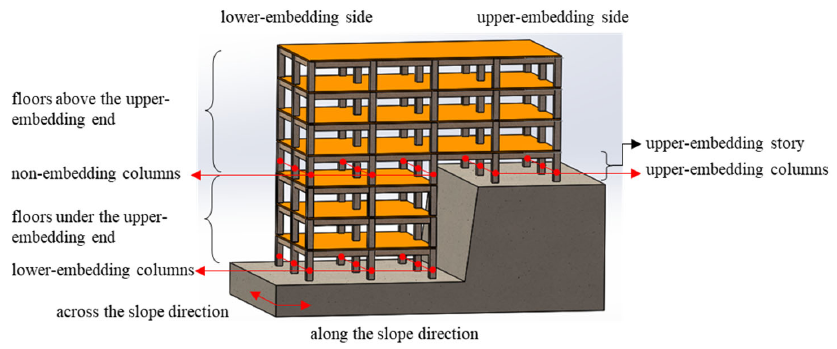
Figure 1. Schematic diagram of the typical MBS and the terminology of each position. A detailed case study is carried out by nonlinear dynamic history analysis using 3 groups of natural waves and 1 group of artificial waves on a typical RC MBS with two different elevations. The structural response in the form of base shear, story shear, column shear, and plastic hinges are obtained, and the laws of redistribution of internal force and damage path are discussed. For subsequent parameter analysis, MBSs with different structural arrangements are established and analyzed, and the influence of structural con ‐ figuration is investigated. The flow chart is shown in Figure 2. Figure 2. The flow chart of the present work. 3. Seismic Response Analysis of an Example MBS Model In this section, an RC ‐ frame MBS supported by foundations with two different ele ‐ vations is built as the example model. The distribution and redistribution of shear force are obtained, and the distribution and development of plastic hinges are investigated. The failure path and mechanism of the structure will be discussed. 3.1. Analytical Model and Earthquake Waves Figure 3 shows an RC ‐ frame MBS with 3 × 2 bays and 6 stories supported by founda ‐ tions with different elevations, named M0. The x ‐ axis is along the slope direction, and the y ‐ axis is across the slope direction. The floor height is set constant at 3.0 m, and the bay width is 6.0 m in both horizontal directions. The cross sections of columns and beams are respectively 600 mm × 600 mm and 300 mm × 600 mm. The thickness of the floor slab is 140 mm to meet the deflection requirements, and there are no secondary beams. The additional uniform dead load and the uniform live load are respectively set as 1.5 kN/m 2 and 2.0 kN/m 2 for all floors. The linear dead load of the infilled walls is 9 kN/m on all beams from the 1st floor to the 5th